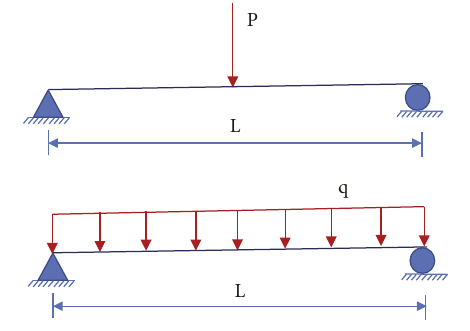
Figure 3: Diagram of the rotation capacity experiment.